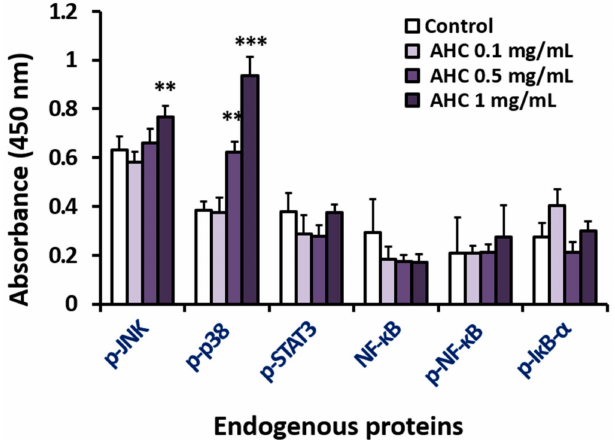
Figure 5. E ff ects of the AHC extract on the stress activated MAPKs and inflammatory markers in MCF-7 cells. Levels of endogenous proteins after 24 h treatment were detected by enzyme-linked immunosorbent assay (ELISA). phospho-p38 (p-p38), phospho-JNK (p-JNK). Control: 0.1% DMSO in culture medium. Data of ** p < 0.05 and *** p < 0.005 vs.